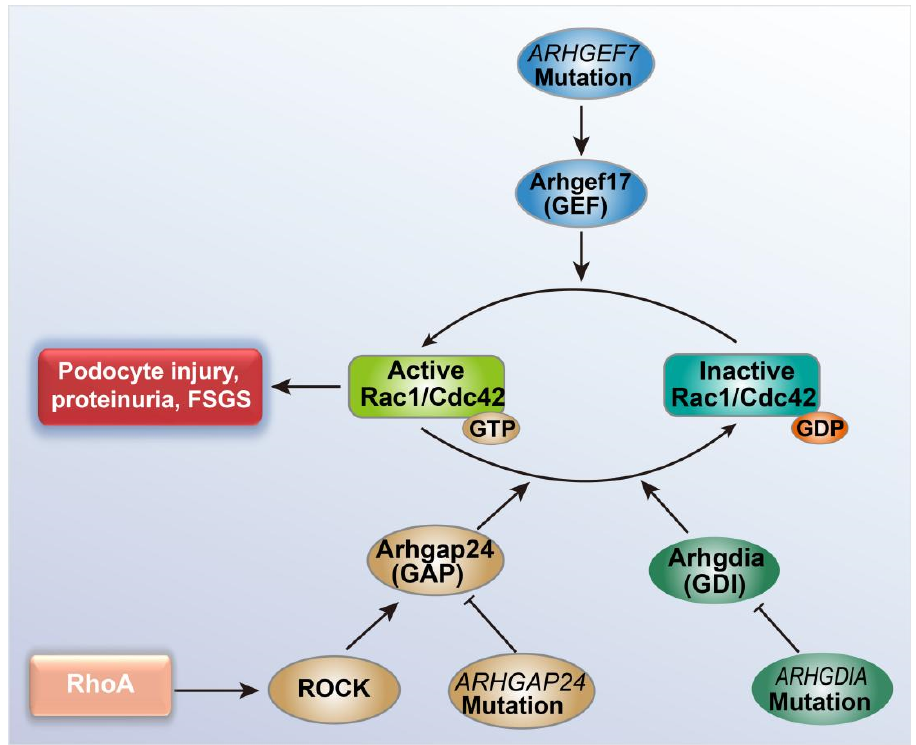
Figure 1. The relationship between FSGS and Rac1/Cdc42 activity transition. Rac1/Cdc42 changes from the GDP binding-inactive state to the GTP binding-activated state, which can cause FSGS characterized by podocyte damage and proteinuria. RhoA can activate GTPase activating protein Arhgap24 through its effector Rho kinase ROCK to inhibit this conversion. The ARHGAP24 , ARHGDIA , and ARHGEF17 gene mutations in FSGS can increase the activity of Rac1/Cdc42 by inhibiting GAP activity and promoting GEF activity, respectively. Abbreviations: FSGS, focal seg- mental glomerulosclerosis; Arhgap24, Rho GTPase activating protein 24; GAP, GTPase activating protein; ROCK, Rho-associated kinase; Arhgdia, Rho GDP-dissociation inhibitor; GDI, GDP-disso- ciation inhibitor; Arhgef17, Rho Guanine Nucleotide Exchange Factor17; GEF, guanine nucleotide exchange factor.